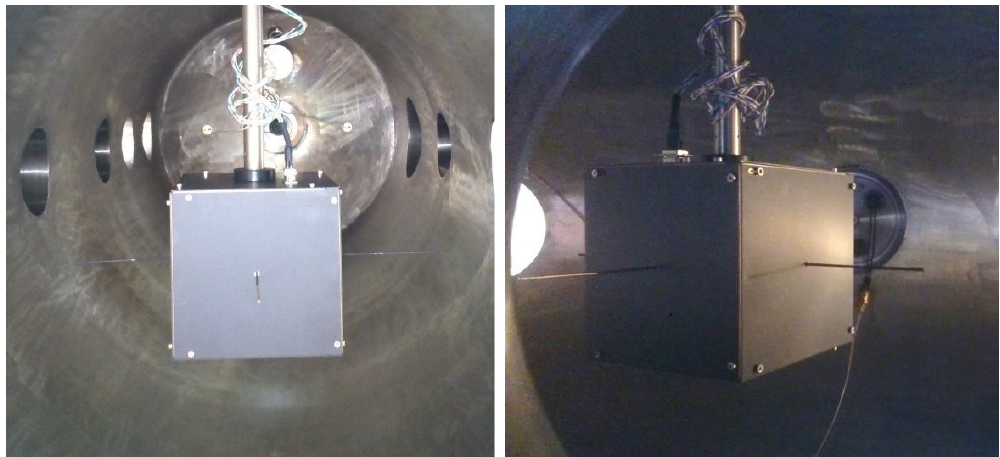
Figure 6. Picture of the electrically representative PICASSO mock-up in the plasma chamber.